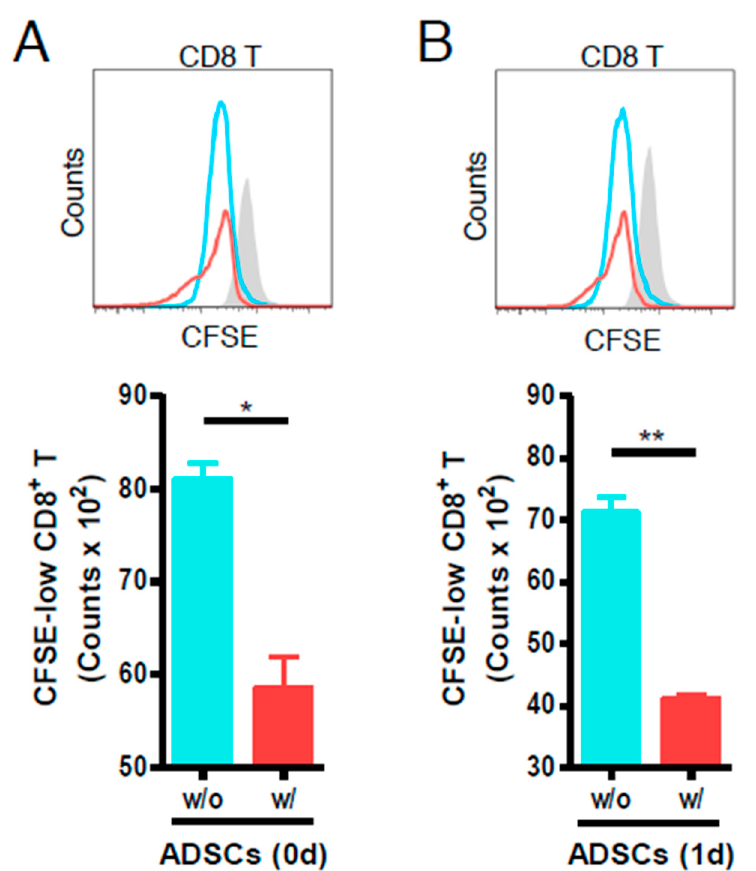
Figure 2. Immunosuppressive effects of human ADSCs on the proliferation of artificially stimulated mouse T cells. Mouse CD3 T cells were stimulated with plastic-coated anti-CD3 and soluble anti-CD28 antibodies in a 24-well plate. ( A ) CD3 T cells were suspended (at 1 × 10 5 cells/well) with ADSCs (at 7 × 10 4 cells/well) on the day of the stimulation ( n = 4 (w/o), n = 5 (w/)). ( B ) CD3 T cells were suspended at 1 × 10 5 cells/well on the day of the stimulation and ADSCs were added at 7 × 10 4 cells/well on the day after stimulation of T cells ( n = 4 (for each sample)). Carboxyfluorescein succinimidyl ester (CFSE)-low-CD8 T cells were analyzed by flow cytometry on day 4 after stimulation. T cells cultured with ADSCs are red line and T cells without ADSCs are sky blue line. CFSE-labeled T cells that are not artificially stimulated are gray-filled histograms; *, p < 0.05; **, p < 0.01.